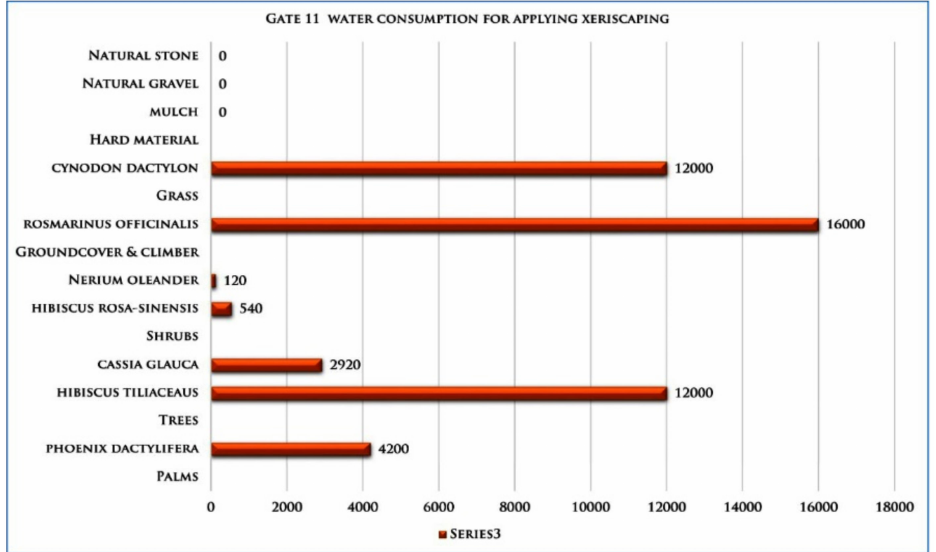
Figure 18. Experiment 3 water consumption quantity after applying xeriscaping items. Xeriscaping softscape design water consumption (Details in Table